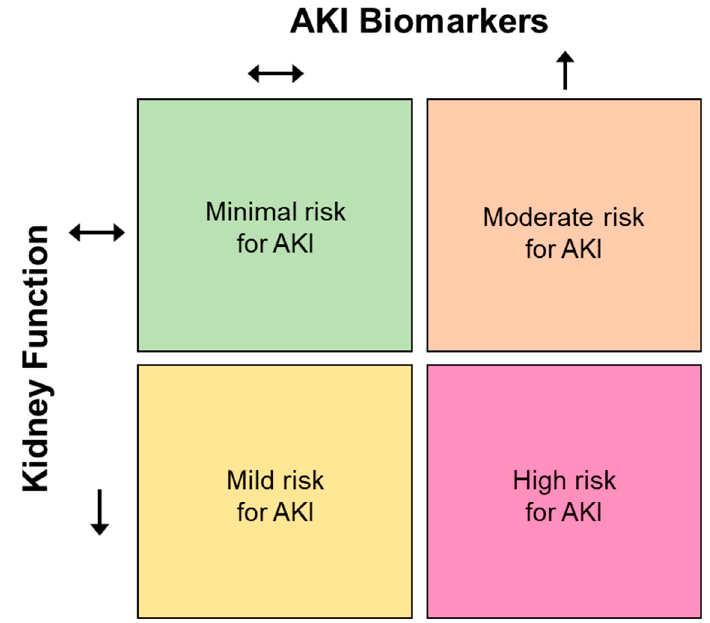
Figure 2. Proposed method for determining the relative risk of developing acute kidney injury (AKI) during exercise in the heat based on changes in kidney function and AKI biomarkers. A decrease in kidney function without increases in AKI biomarkers may be indicative of a relatively mild risk for AKI because the renal changes are unlikely to be pathological (bottom-left). Increases in AKI biomarkers without a change in kidney function may be interpreted as a slightly higher (i.e., moderate) risk of AKI, owing to the presence of potential pathological processes (top-right). The highest risk of AKI may occur when kidney function is reduced alongside increases in AKI biomarkers (bottom-right). AKI risk could be further delineated based on the magnitude of the reductions in kidney function and/or increases in AKI biomarkers.